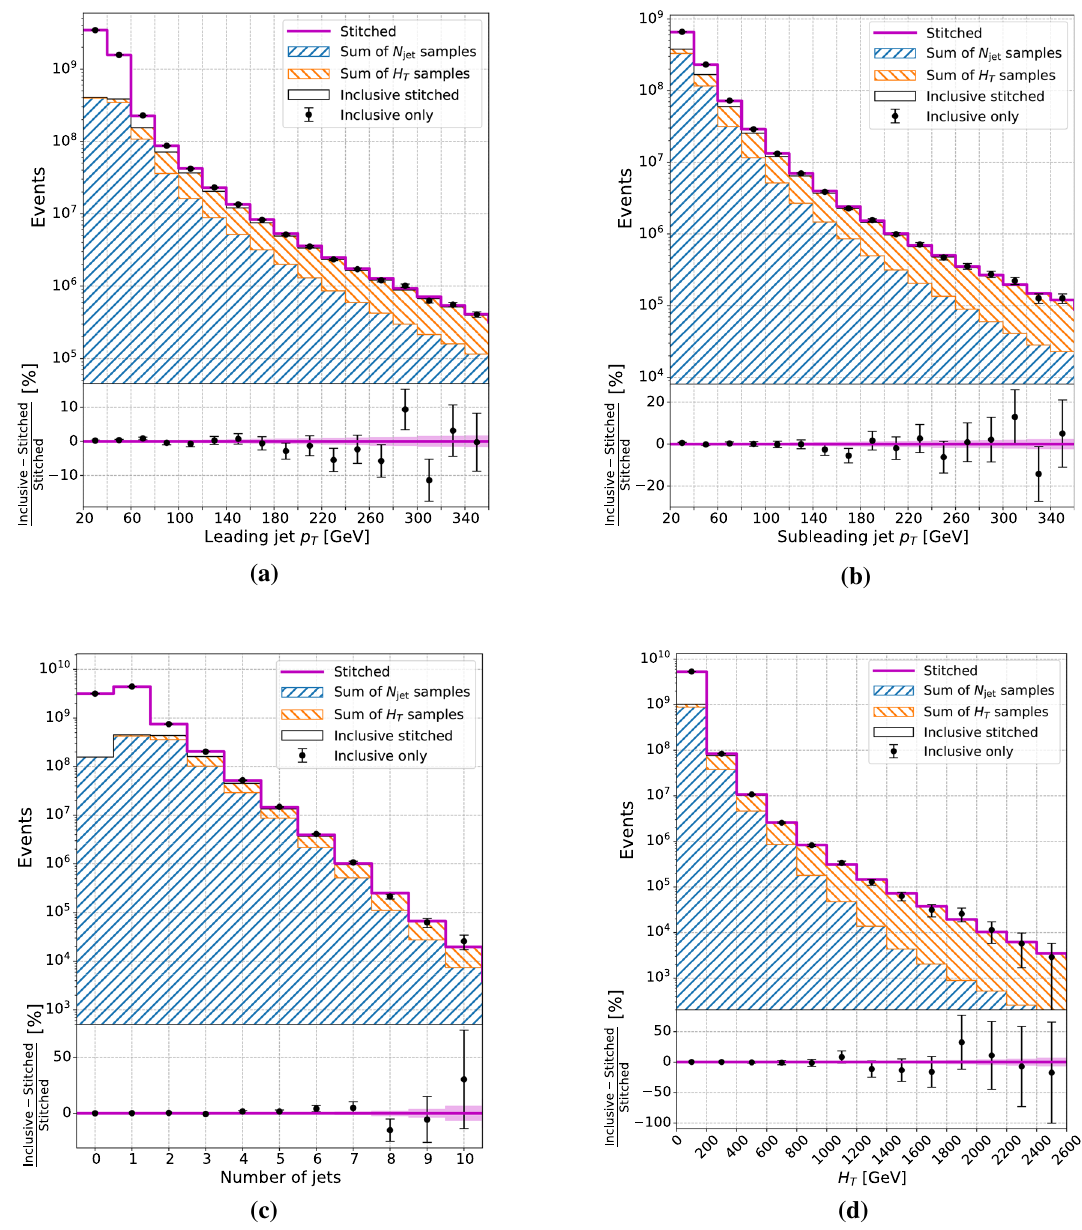
Fig. 3 Distributions in p T of the a leading and b subleading jet, in c the multiplicity of generator-level jets and in d the observable H T , the scalar sum in p T of these jets, for the case of W+jets samples that